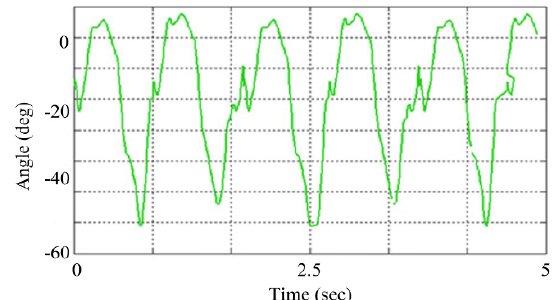
Figure 8. Example of the angle-time diagram of knee joint of a children with cerebral palsy.